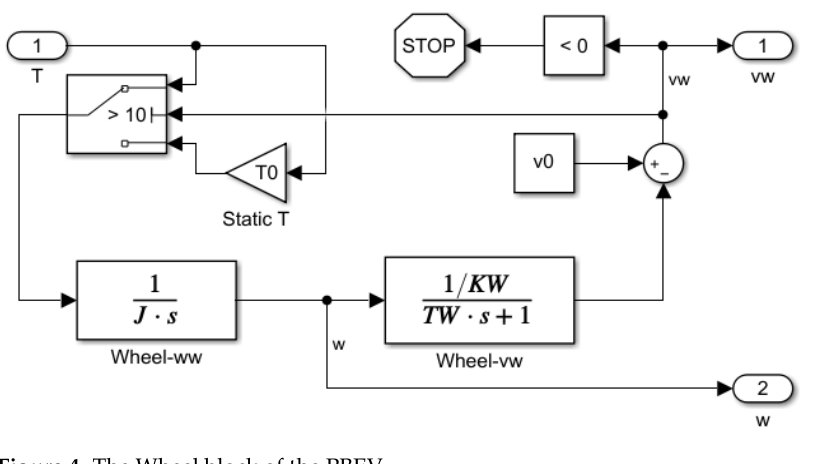
Figure 3. The replacement circuit of the electrical drive used for NN learning.